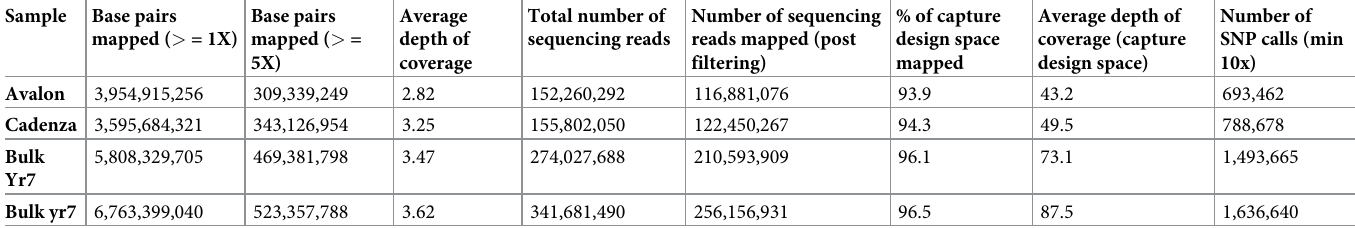
Table 1. Summary of mapping statistics across the pseudo-chromosome reference. Mapping depth of coverage of the pseudo-chromosome reference and SNP num- bers that were identified for the purebred parental lines Avalon and Cadenza plus the bulks. Sample Base pairs Base pairs mapped ( > = 1X) mapped ( >